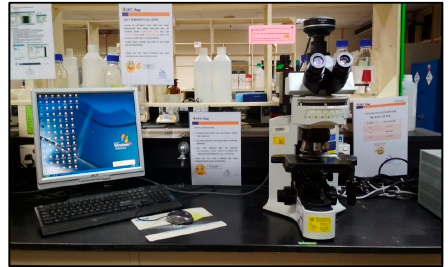
Figure 1. OLYMPUS BX41 digital microscope.